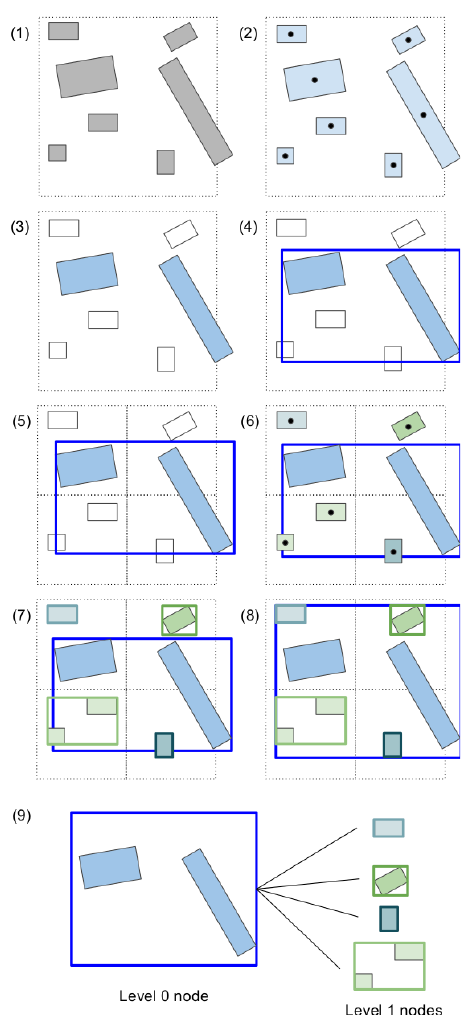
Figure 4: Initialisation algorithm for n = 2. (1) Initial state. Dashed square is the initial quadtree tile, covering the extent of the scene. (2) Assigning features to the node. (3) Selecting highest-weight features. (4) Computing bounding box. (5) Re- cursion, since all features are not assigned to a node yet. Creating child nodes using quadtree subdivision. (6) Assigning features to nodes. (7) Computing bounding boxes. (8) Adjusting parent bounding box. (9) The resulting structure. Figure 4 goes through the classification process for a simple case. The algorithm is described hereafter. The numbers refer to the figure’s corresponding